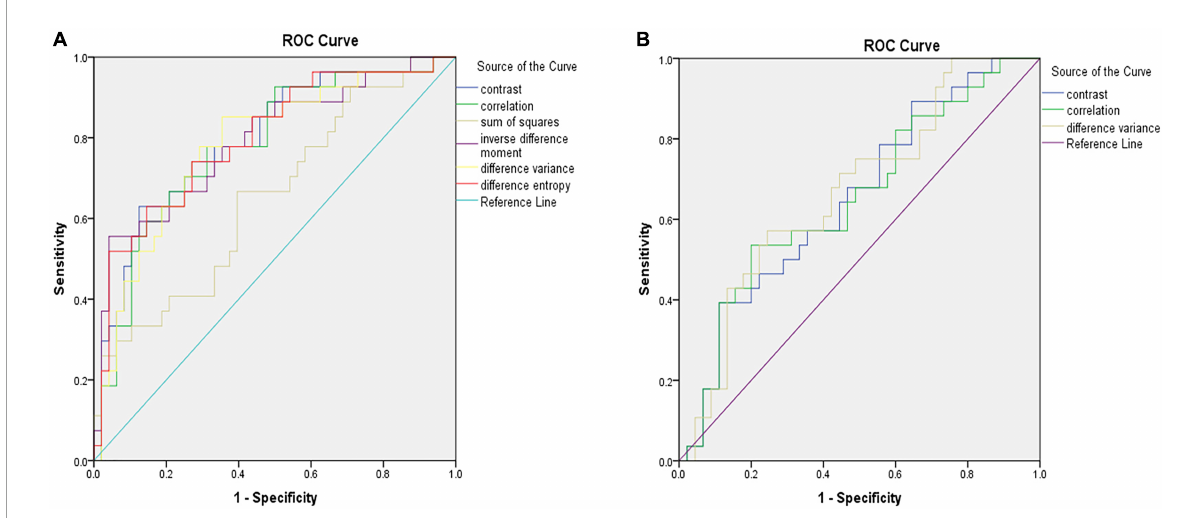
FIGURE4 ROC analysis showing the best model for predicting hemorrhagic transformation (HT) in patients with acute massive cerebral infarction (MCI). Illustration of the accuracy of six texture analysis features (f2, f3, f4, f5, f10, and f11) in terms of ROC curves for predicting HT based on diffusion weighted imaging (DWI) (A) . Illustration of the accuracy of three texture analysis features (f2, f3, and f11) in terms of ROC curves for predicting HT based on T2-weighted-fluid-attenuated inversion recovery (T2/FLAIR) (B) . ROC, receiver operator characteristic.